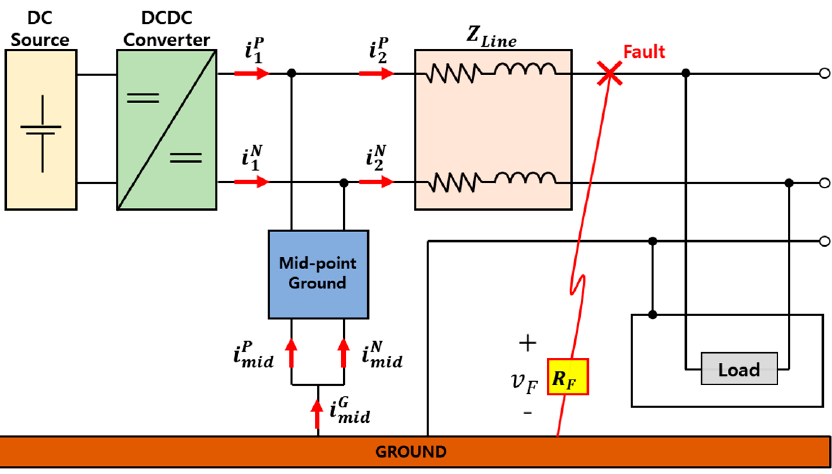
Figure 9. Configuration of the simulation circuit developed in MATLAB/Simulink. Table 5. Simulation parameters.